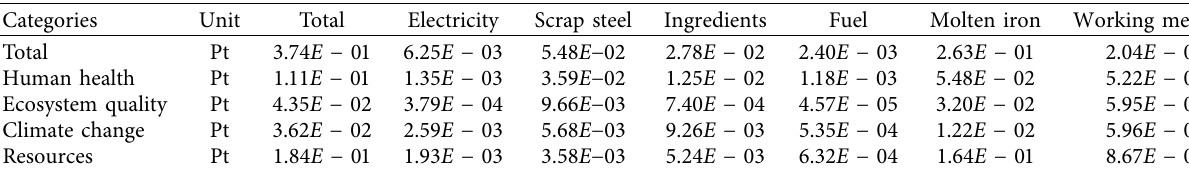
Figure 2: Normalized midpoint results. Table 3: Life cycle assessment endpoint results of molten